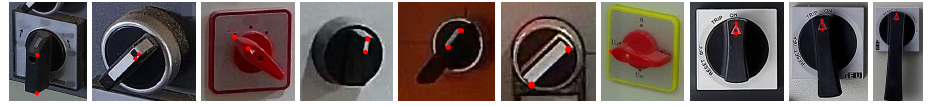
Figure 3. Ten different types of knobs with different feature distributions of key